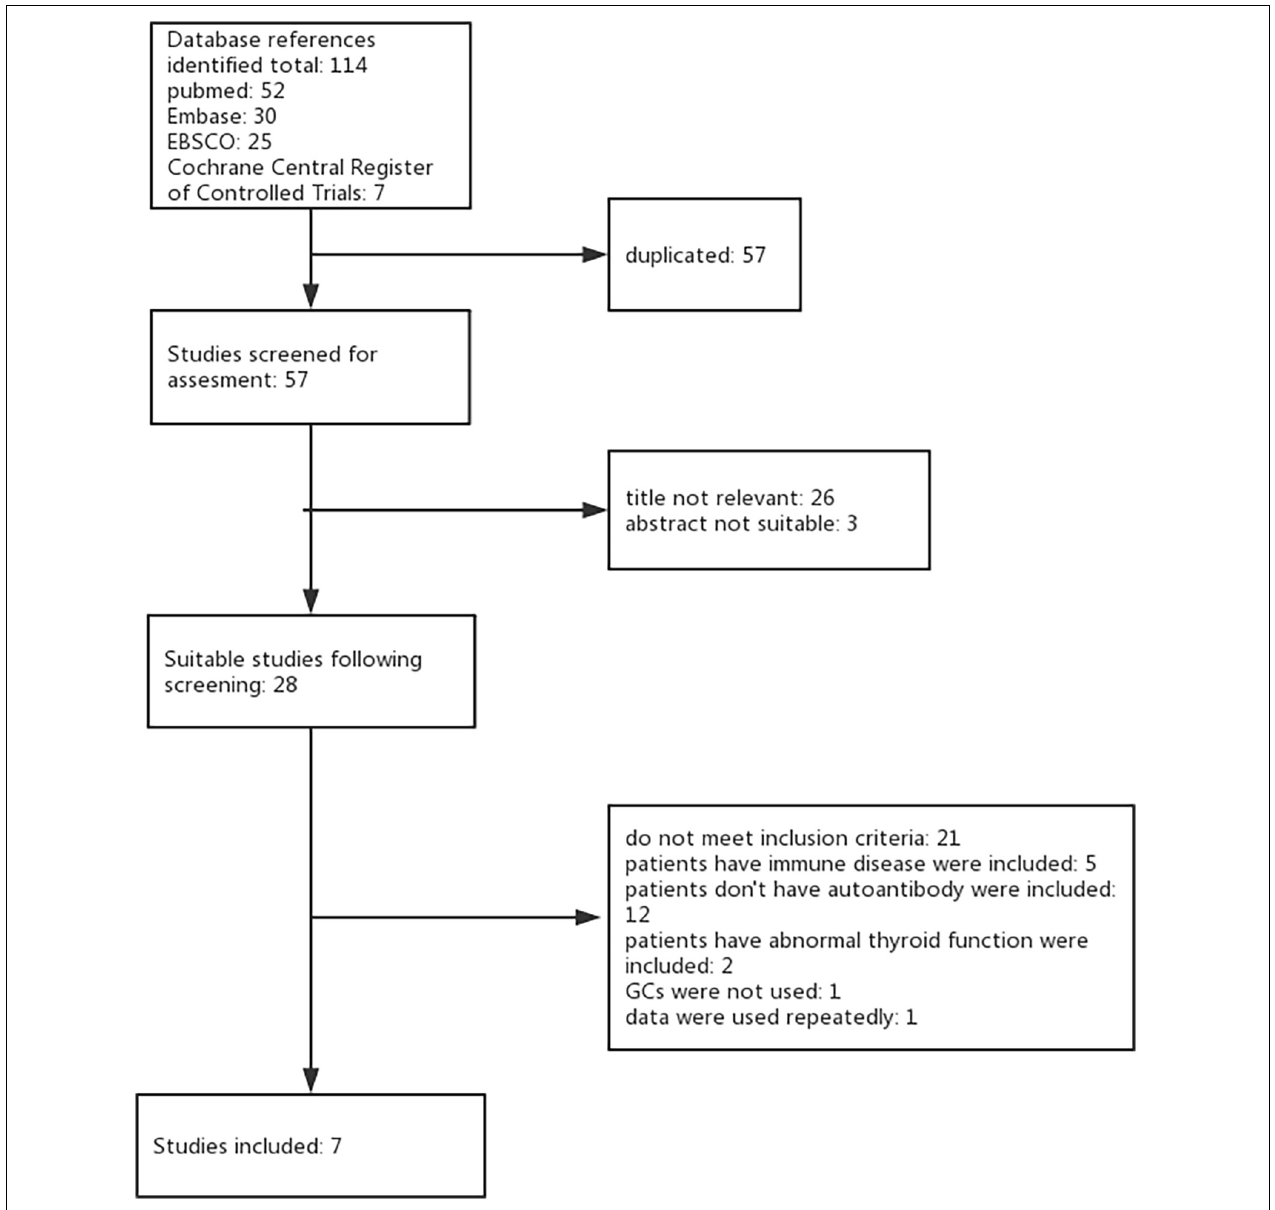
FIGURE 1 | The process of finding